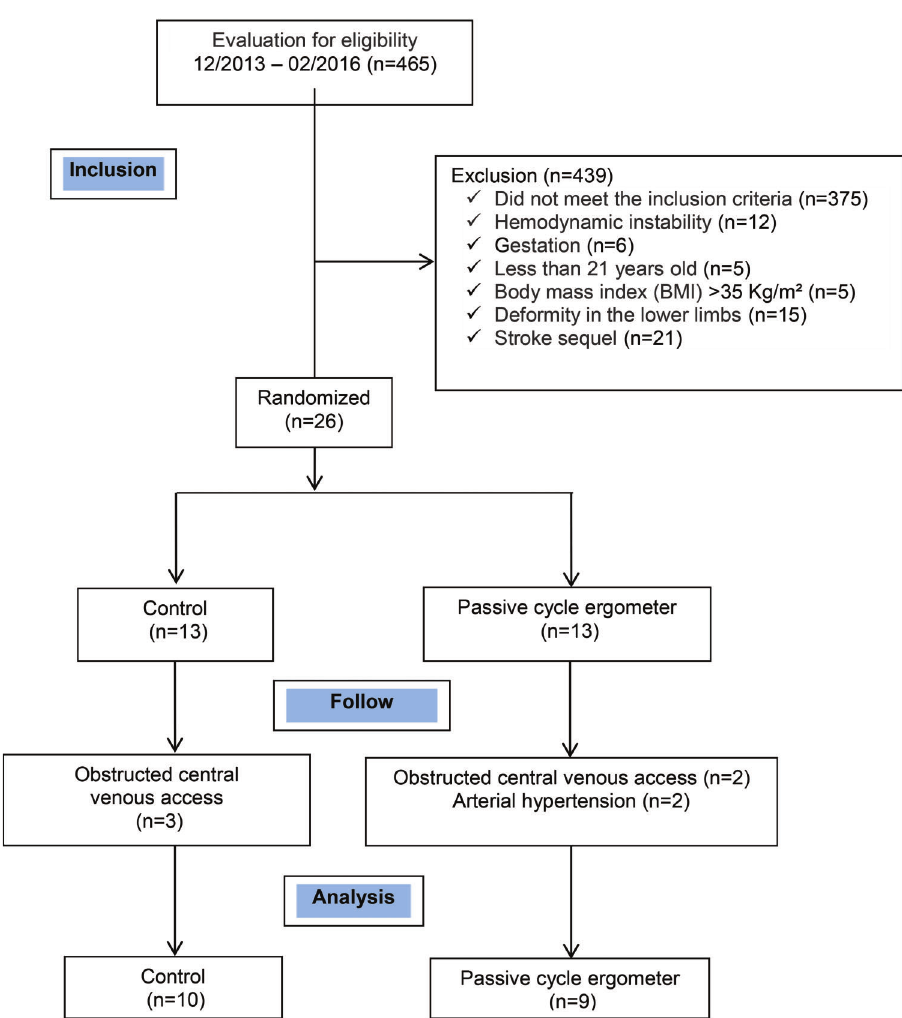
Figure 2 - Flowchart of the patients who participated in the